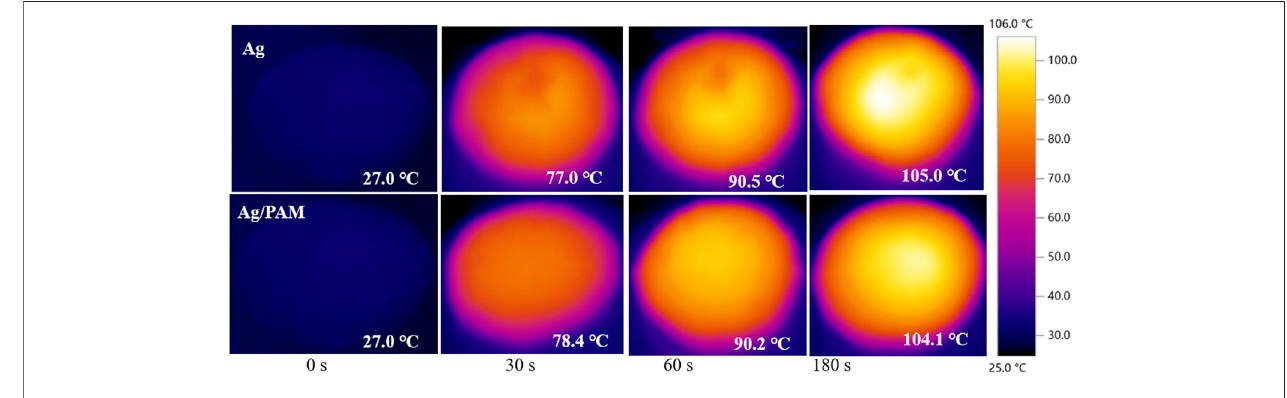
FIGURE 3 | Infrared images of Ag and Ag/PAM materials under 1 sun